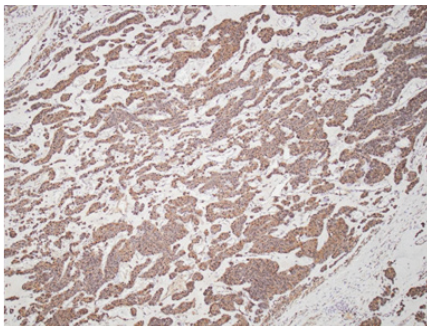
Figure 5: Immunohistochemical staining of glomus tumor, synap- tophysin